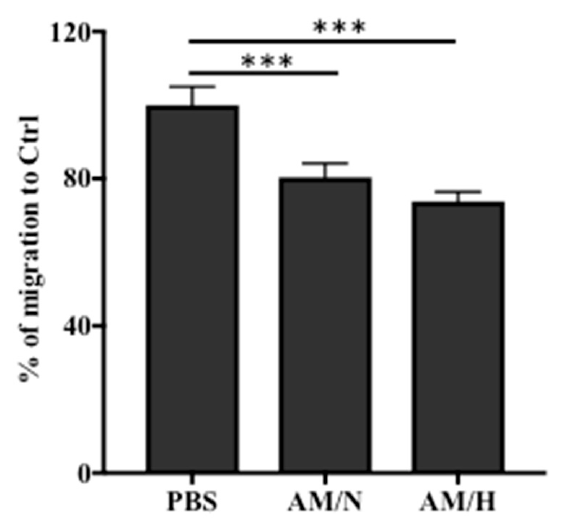
Figure 5. Effect of AM exosomes on the migration of LX-2 cells in a scratch wound assay. Non-activated LX-2 cells were cultured to confluence. A scratch wound was created, and images were captured at time 0. After incubation with PBS or exosomes for 24 h, the wound areas were imaged. The migration of LX-2 cells was expressed as a percentage relative to the wound closure in the control (PBS) group. Three areas of each wound (6 wounds/treatment) were quantified. Data are presented as mean ± SD ( n = 6). *** p < 0.005.